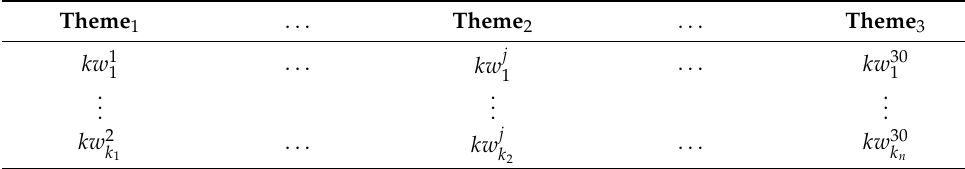
Table 2. Keywords classified into 30 themes.